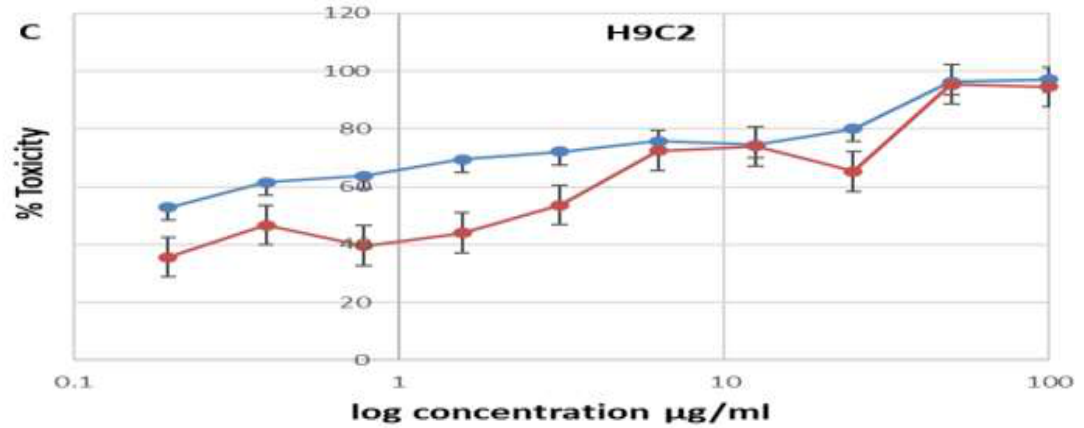
Figure 3. Log concentration versus toxicity of DOX and DOX+BA+RSV (1:1:1) combination against H9C2